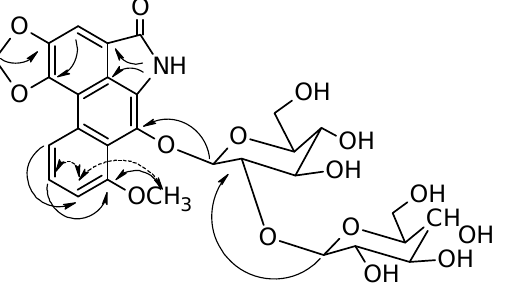
Figure 2. Selected g HMBC ( → ) correlations and nOe ( ↔ ) interactions for aristolactam 10 .